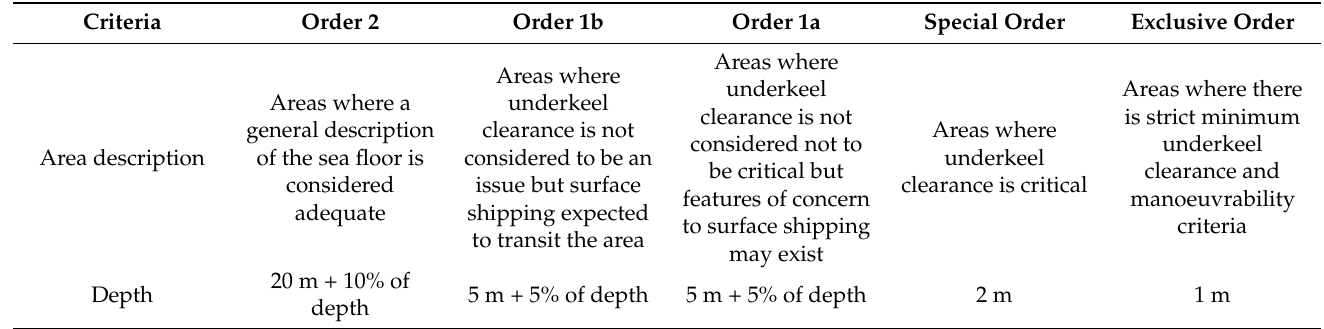
Table 1. The requirements for positioning accuracy during the hydrographic survey performance under a specific order [24].